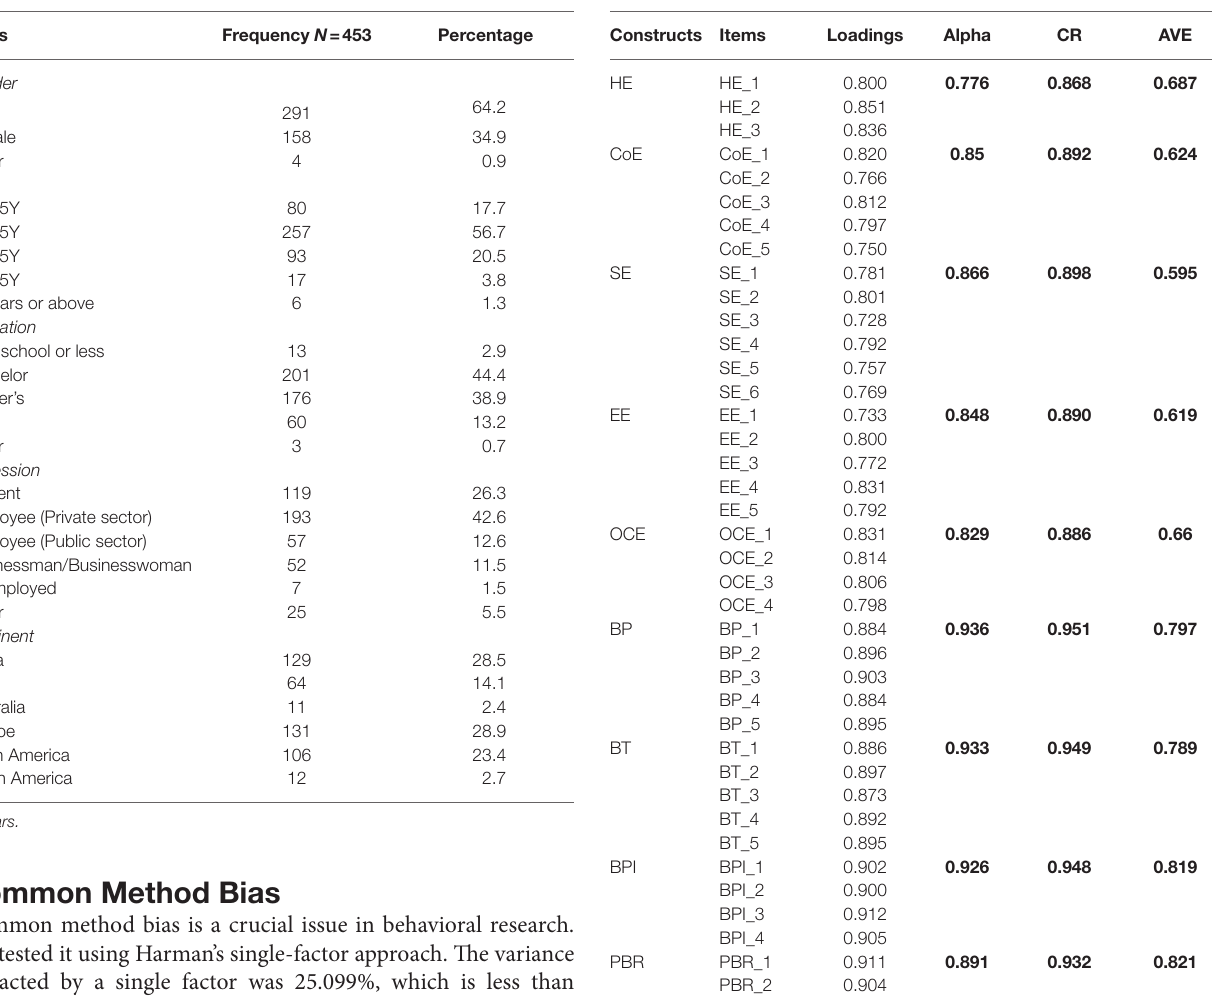
TABLE 1 | Demographics of respondents. TABLE 2 | Alpha, composite reliability, and average variance extracted